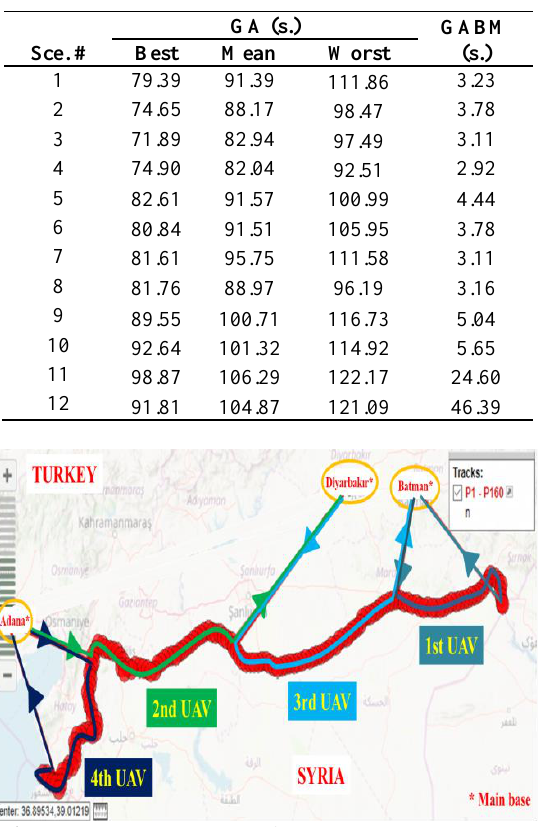
Figure 10. The optimal route for scenario #12 with 4 UAVs The borderline between Turkey and Syria is selected for the case study. Bayraktar UAV is chosen considering the usage of it in real life. 12 realistic scenarios are generated covering four airbases and 152 grid points on the borderline. While considering scenarios, the usage of active bases and the number of daily patrols done by UAVs are changed. The scenarios are solved with GA and GABM. In half of the scenarios, GABM improved the GA results and decreased the used number of UAVs and the total travel distances. Especially for more complex scenarios, GABM developed the results much effectively in reasonable CPU